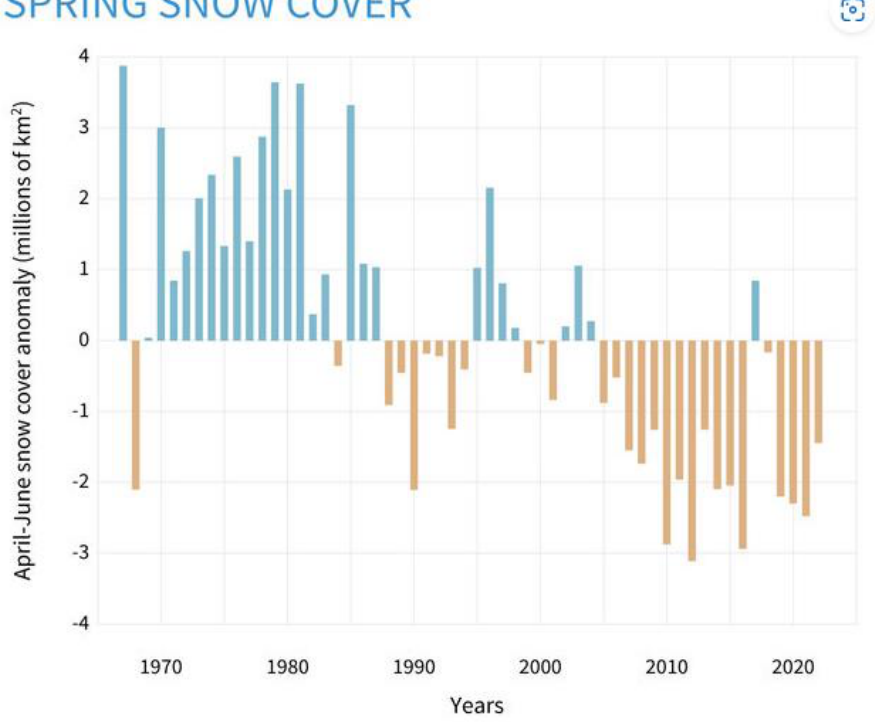
Figure 5. Spring (April–June) snow extent each year compared to the 1981–2010 average for the northern hemisphere. Years with above-average snow cover are blue-green, while years with below- average snow cover are brown. Graph by NOAA Climate.gov, based on Rutgers Snow Lab data provided by Thomas Estilow.